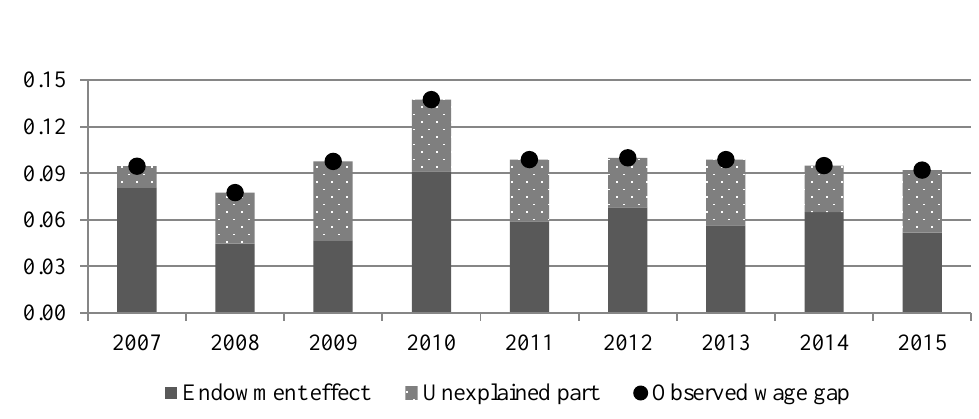
Fig. 1. Decomposition of the ethnic wage gap (log points; 2007−2015). *Difference in % can be calculated as exp (difference in log points)-1 Source: authors’ calculations using LFS micro data